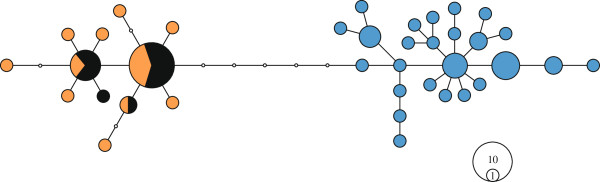
Minimum-spanning haplotype network based on a partial sequence of cytb (276 bp). The non-overlapping haplotype distribution among continental samples of American (orange, n = 15) and European eels (blue, n = 34) becomes apparent. A fraction of eels (n = 16) sampled in Iceland carry a typical American haplotype (black), and are thus suspected to be of hybrid origin. The scale on the bottom right-hand side indicates the number of individuals sharing a given haplotype.